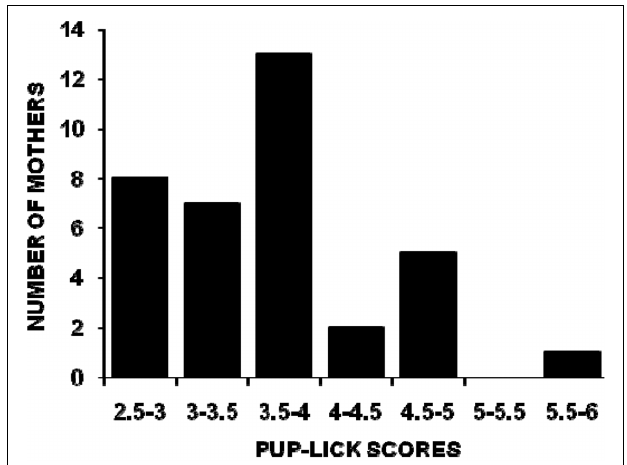
FIGURE 3 |The distribution of mean hourly hover over pups scores (maximum possible score/h = 20) for 36 C57BL/6J mothers over five 1-h observations (two light phase, three dark phase) on postpartum days 2, 4, 6, and